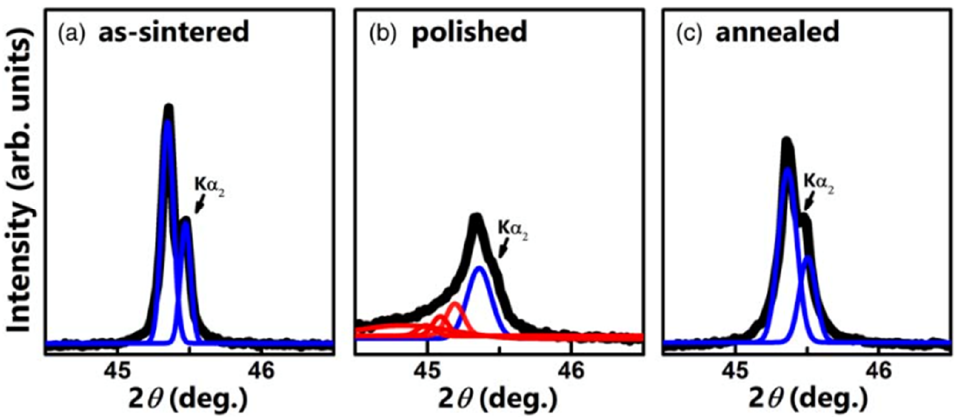
Figure 18. The (200) diffraction peaks of ( a ) as-sintered ceramics with undamaged layers, ( b ) surfaces polished ceramics with damaged and undamaged layers, and ( c ) thermally annealed ceramic’s surfaces. The damaged and undamaged layers on diffraction peaks were identified by profile fitting on Pseudo-Voigt function. Reprinted with the permission of [140]. Copyright (2019) The Japan Society of Applied Physics.